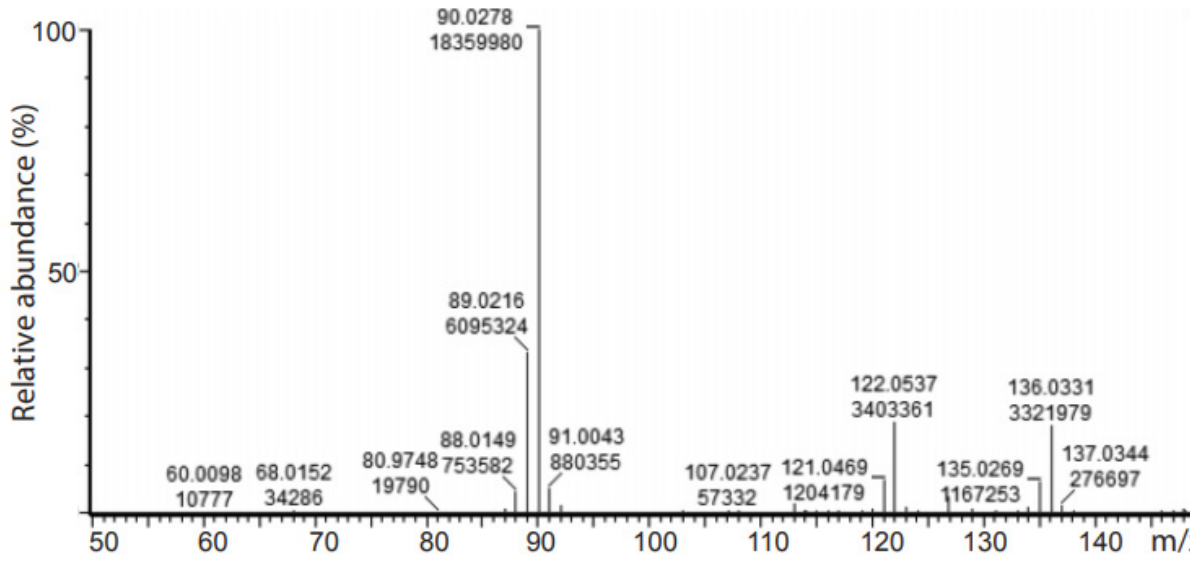
Figure 2. High resolution mass spectrum of the deuterated sodium pyruvate: m / z calculated for C 3 D 3 O 3 – [M–H]–: 90.03; found: 90.03; calculated for C 3 D 2 HO 3 – [M–H]–: 89.02; found: 89.02; calculated for C 3 DH 2 O 3 – [M–H]–: 88.02; found: 88.01.